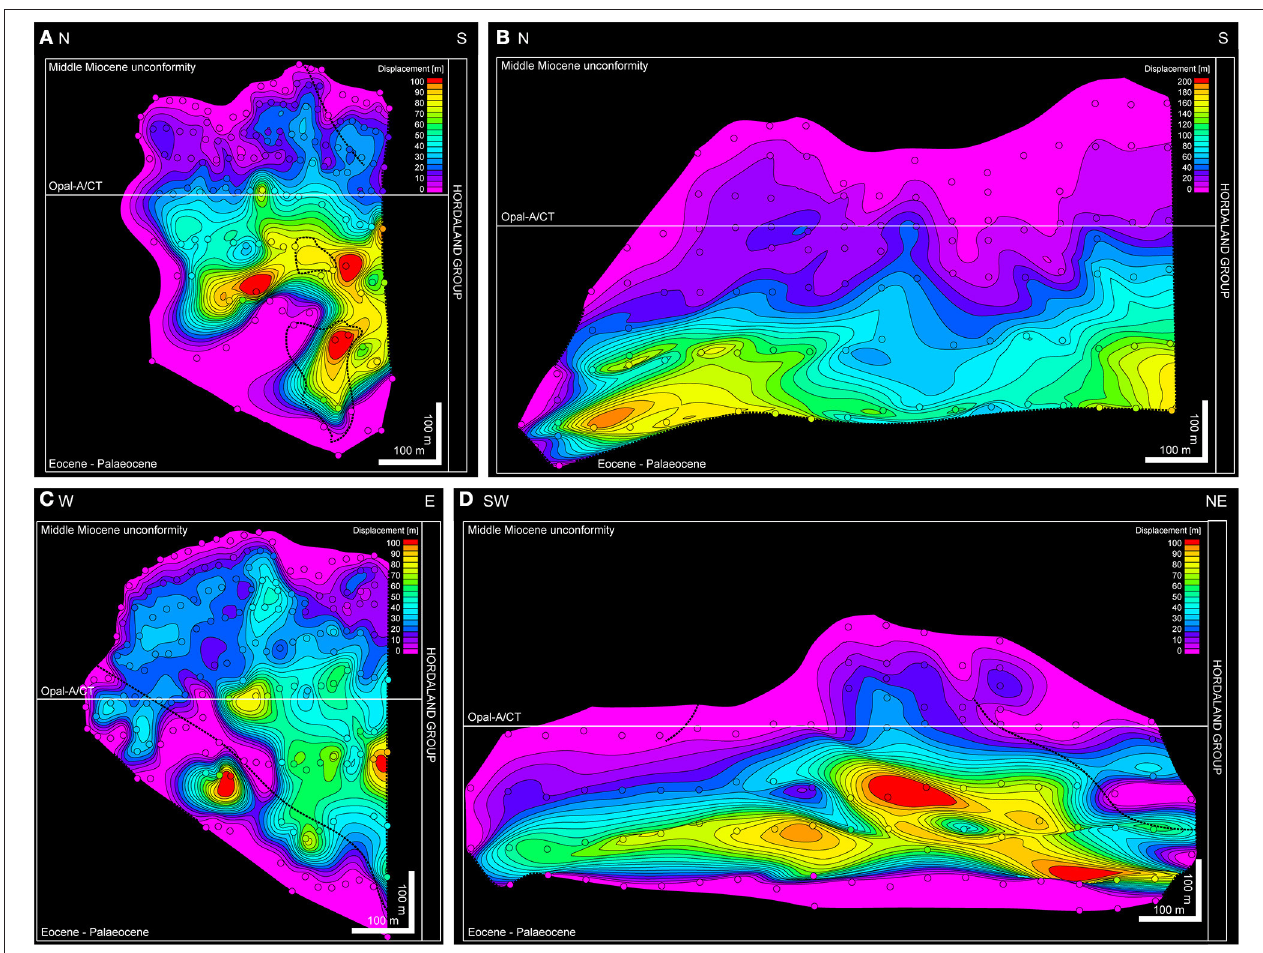
FIGURE 9 | Displacement-strike-projection of four polygonal faults (A–D) . (1) The bulk displacement has been accumulated in the lower Hordaland Group; (2) these faults show multiple displacement maxima at similar depth levels and (3) that they have low displacement gradients ( < 1) at the top. Branch lines are shown as dotted